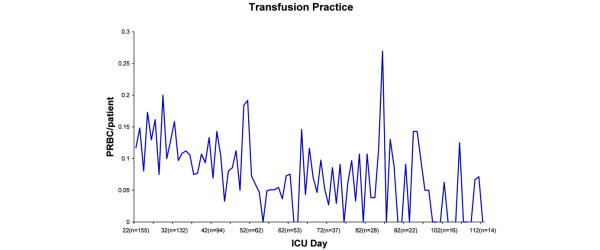
Transfusion over time. ICU, intensive care unit; PRBC, packed red blood cells.